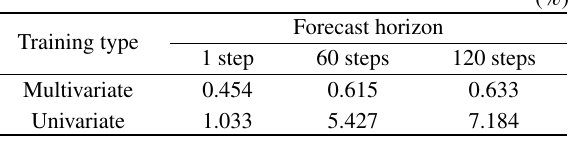
Fig. 4 EV speed forecasting results for the multivariate LSTM model, (a) one step, (b) 60 steps, and (c) 120 steps. Table 1 RMSE